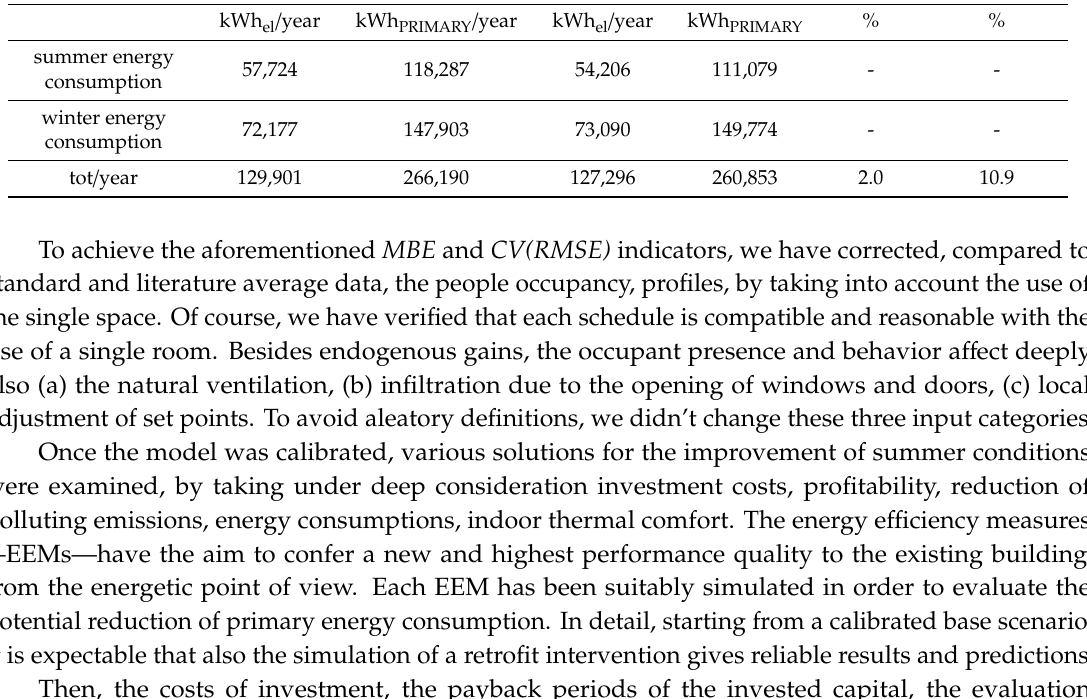
Figure 3. Monthly comparisons of energy demands between monitored and simulated data. Table 3. Energy consumption (all energy uses) for the calibration of the numerical model. Calibration Data